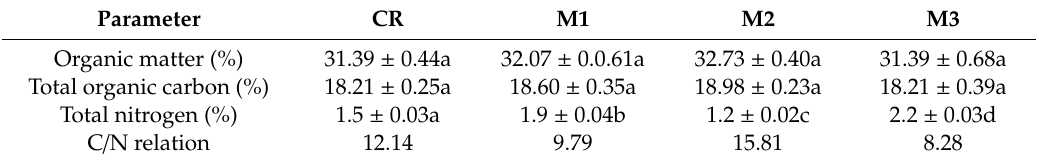
Table 3. Characterization of the four pineapple waste and load material mixtures after vermicomposting. Parameter CR M3 Organic matter